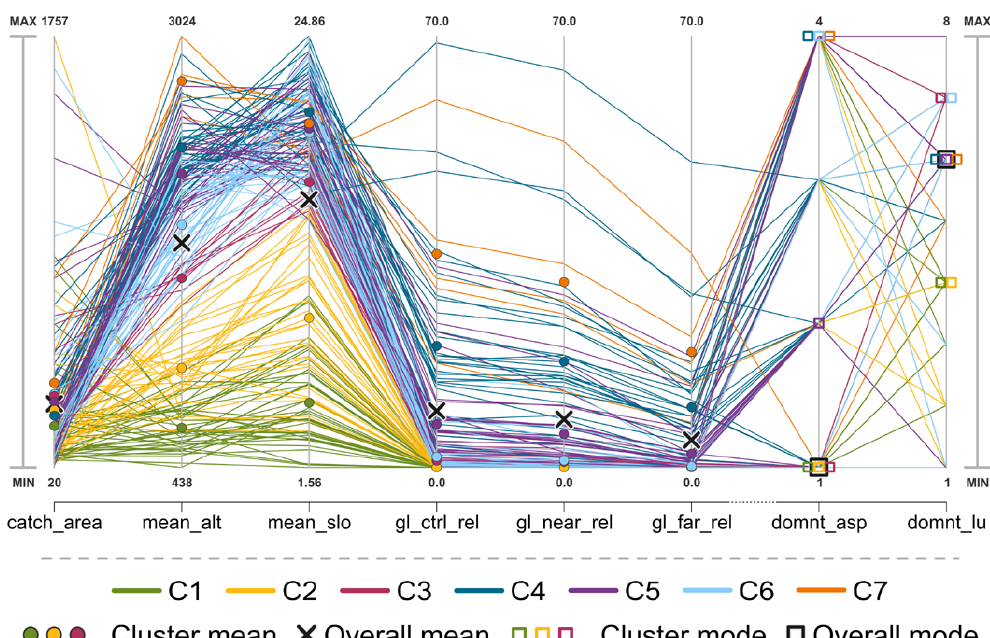
Fig. 4. Parallel coordinates plot of the physiographic catchment properties (for abbreviations and class descriptions of the nominal variables dominant aspect and dominant land use, see Table 1). Each parallel axis displays one physiographic variable, and each curve represents a catchment. The curves are colour-coded according to the cluster a catchment is assigned